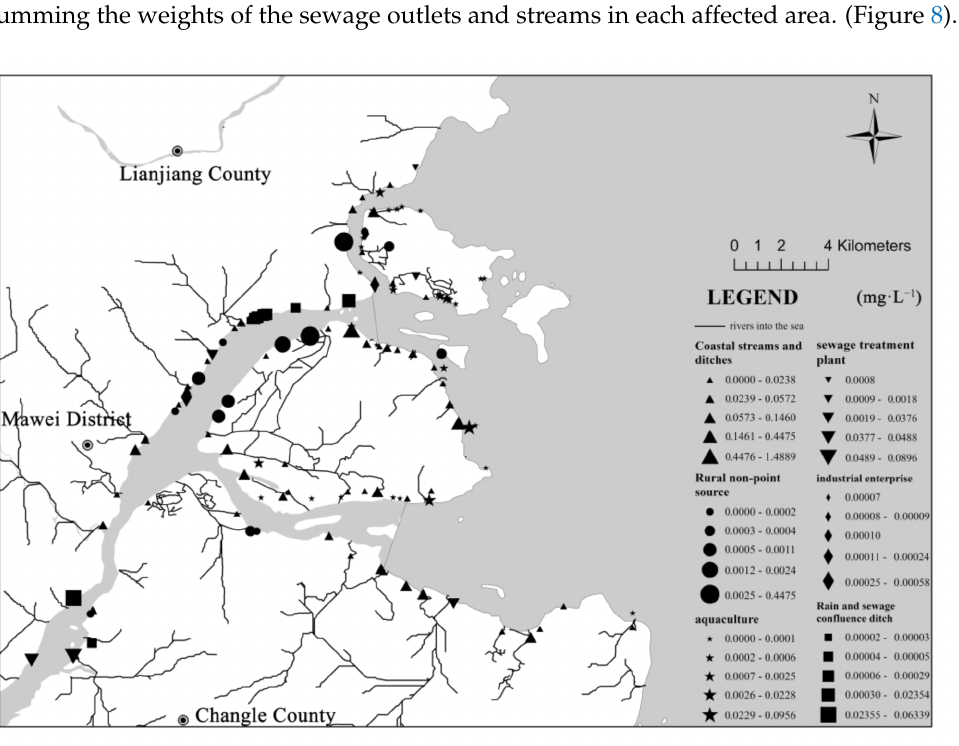
Figure 7. Proportion of DIN contribution from various types of sewage outlets in the land area of the Minjiang